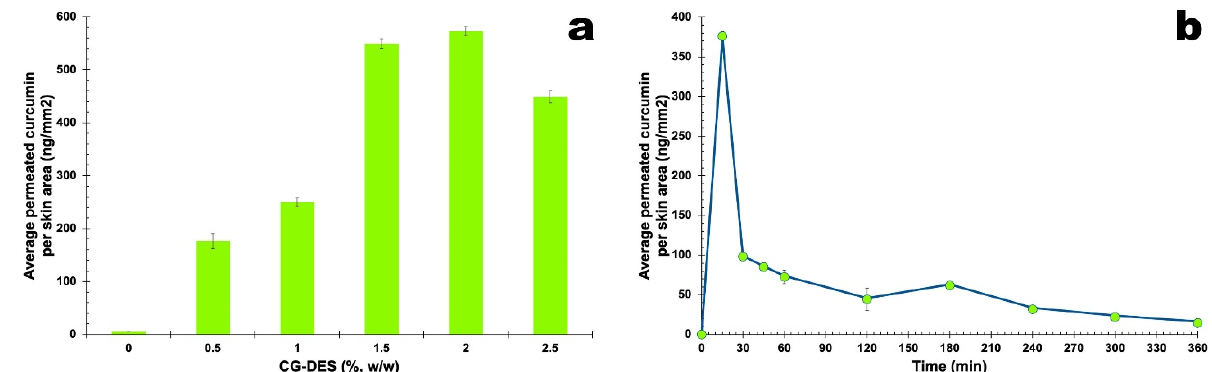
Figure 2. Results gathered from transdermal permeation assays of curcumin aided by CG-DES, as average permeated curcumin (ng/mm 2 ), for several CG-DES concentrations ( a ) and during a 6 h assay using the best CG-DES concentration (viz. 2%, w / w ) ( b ). All values represent the mean of three experiments and the error bars represent the standard deviations.